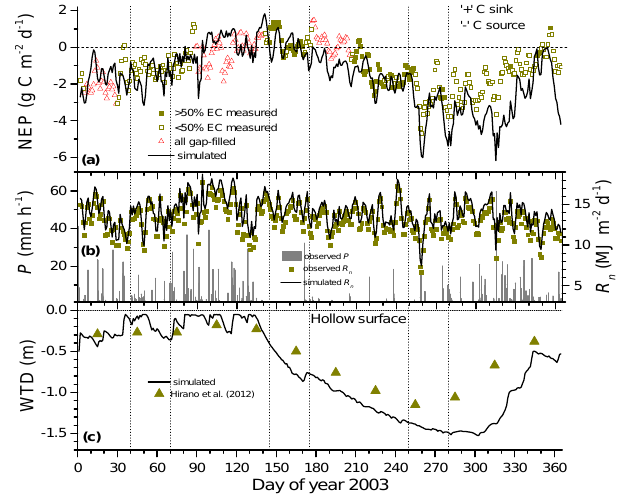
Fig. 2. (a) Three day moving averages of simulated and EC-gap filled estimates of net ecosystem productivity (NEP). Solid squares indicate sums of 24 values more than 1/2 of which were recorded at u ∗ (friction velocity) >0.17ms − 1 , open squares indicate sums of 24 values more than 1/2 of which were gap-filled, and open triangles indicate sums of 24 values all of which were gap-filled; (b) hourly measured precipitation ( P) and three day moving averages of sim- ulated and measured net radiation ( R n ) ; and (c) monthly measured (values digitally obtained from Hirano et al., 2012) and daily mod- elled water table depths (WTD) from hollow surface during 2002 over a drainage affected tropical peat swamp forest at Palangkaraya, Indonesia. Negative values of WTD mean depths below the ground.